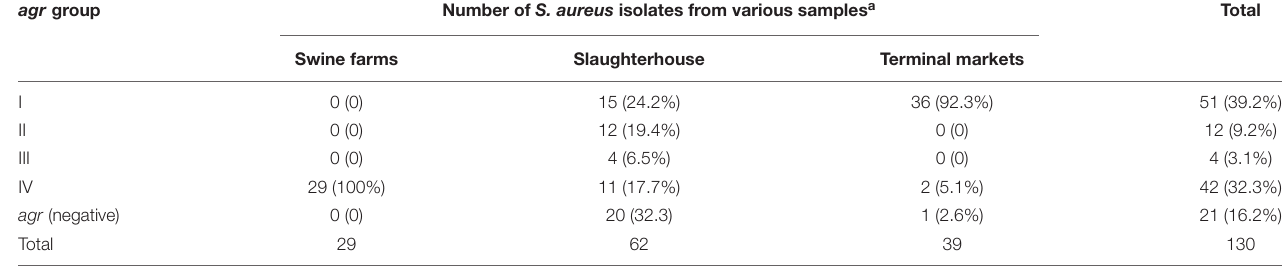
TABLE 2 | The agr types of 130 S. aureus isolates from different stages of pork production. agr group Number of S. aureus isolates from various samples